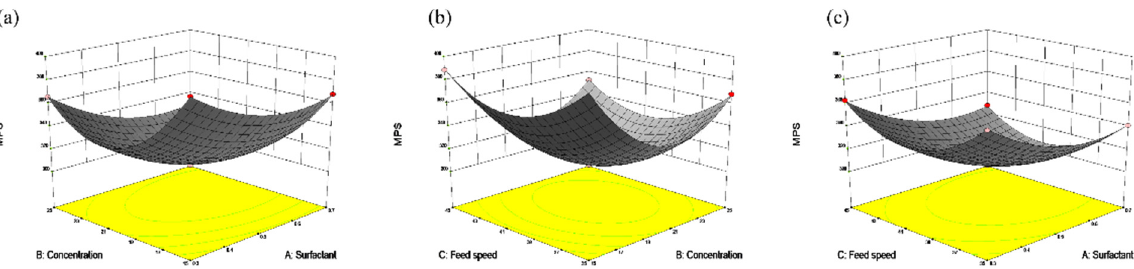
Figure 3. Response surface optimization of NUP particle size (optimization of concentration, surfactant and feed speed factors and levels). ( a ): Effect of concentration and surfactant on particle size, ( b ): The effects of feed speed and concentration on particle size, and ( c ): The effects of feed speed and surfactant on particle size.